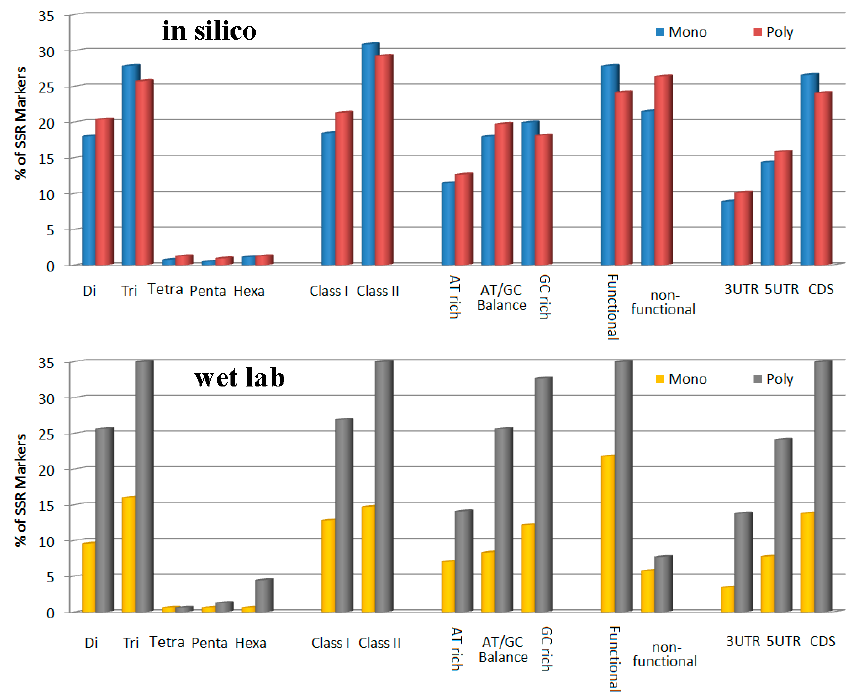
Figure 3. Polymorphic and monomorphic marker distribution among different classes based on in-silico and wet lab analyses.